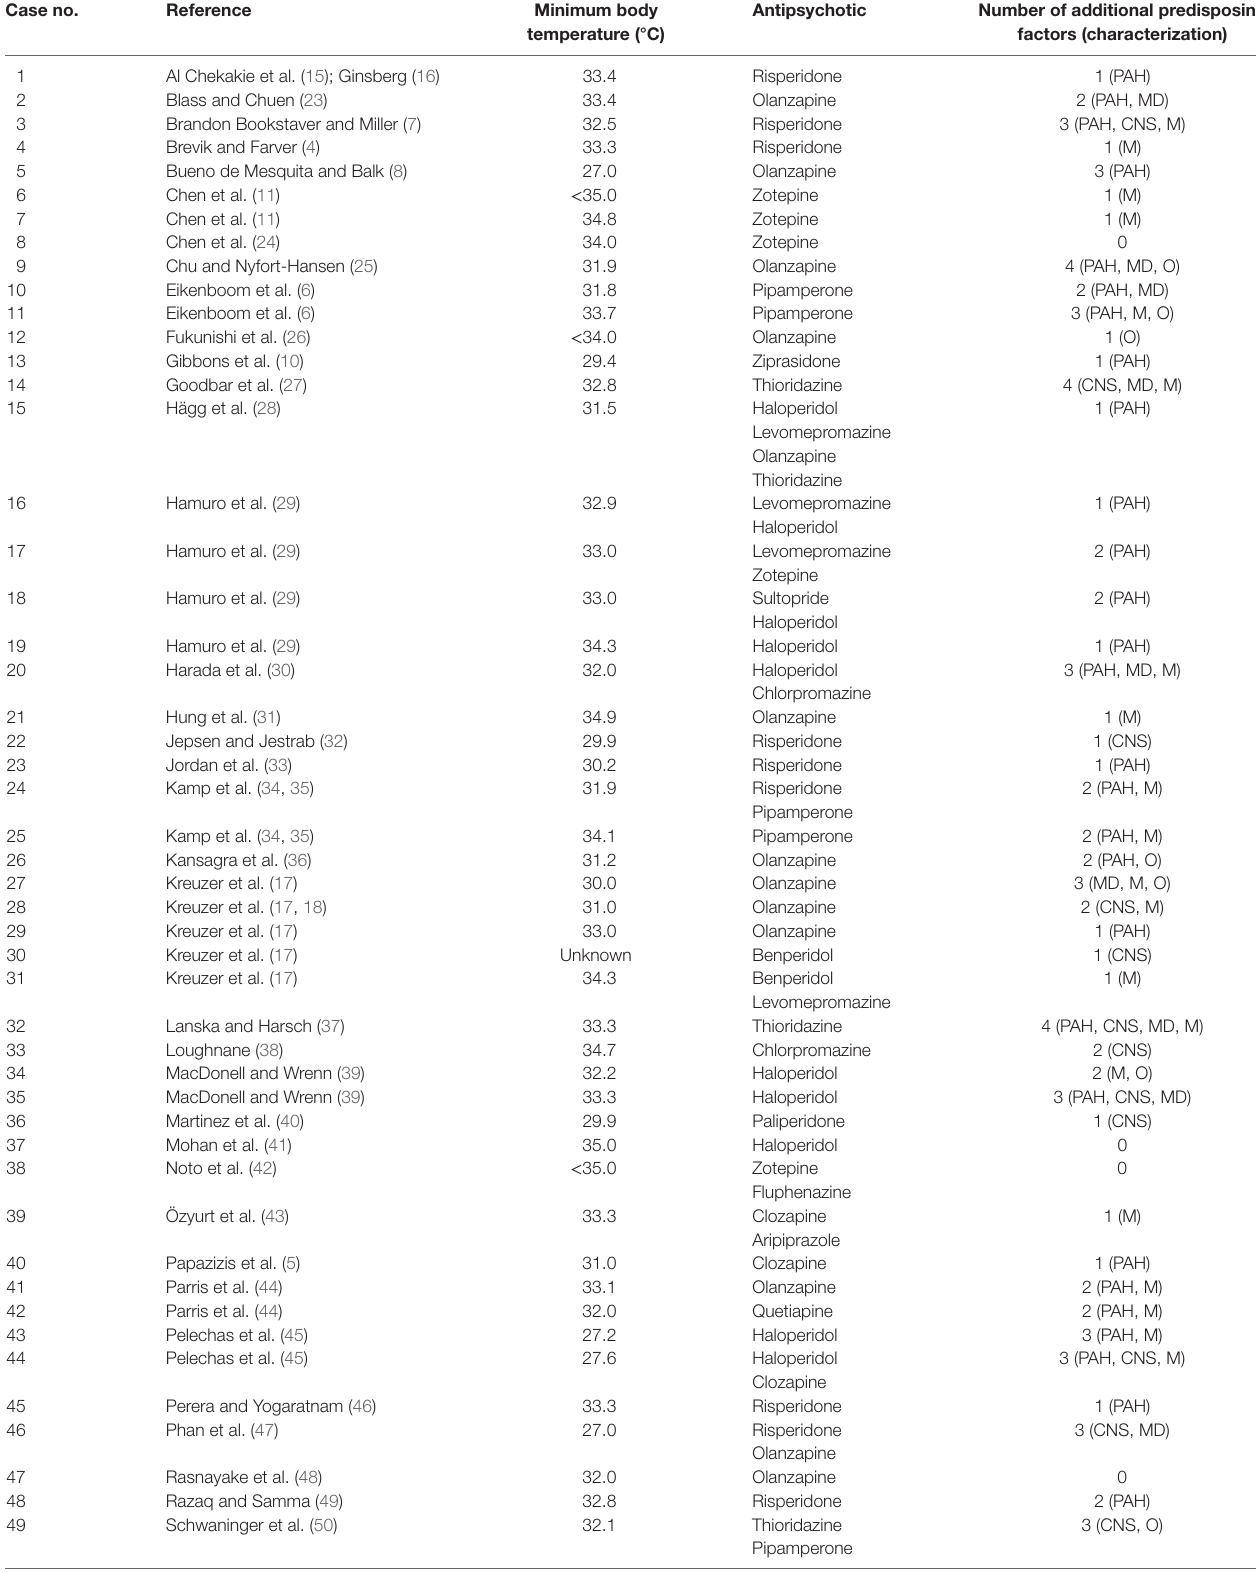
taBLe 1 | Cases of antipsychotic-related hypothermia. case